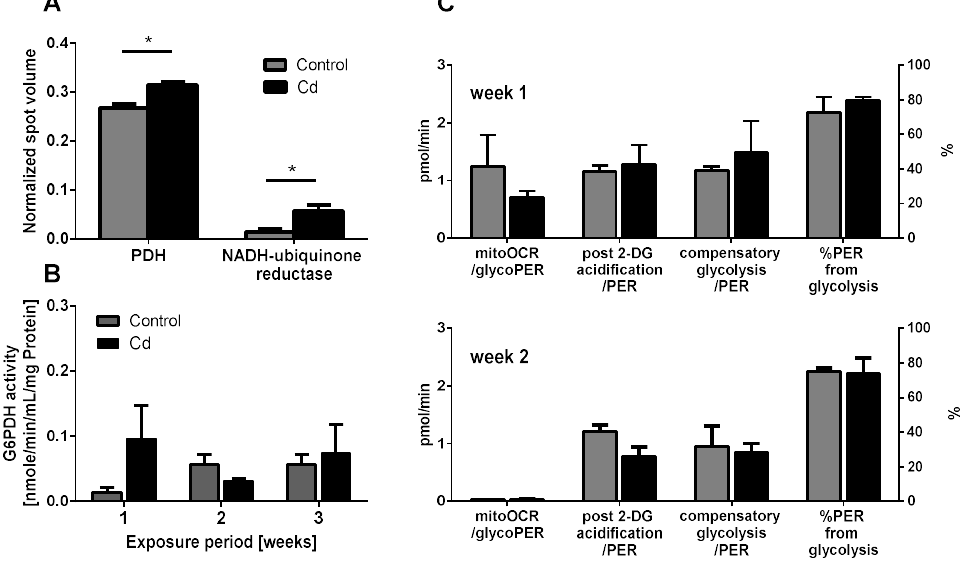
Figure 4. Energy metabolism. ( A ) Proteins related to energy metabolism detected in the proteomics approach. ( B ) Glucose-6-Phosphate Dehydrogenase (G6PDH) activity measurement using coelomocytes derived from control and Cd-exposed earthworms. ( C ) Glycolytic rate assay using coelomocytes from earthworms exposed to control or Cd-spiked soil (50 mg / kg dry soil). * t -test indicates significant di ff erences at p ≤